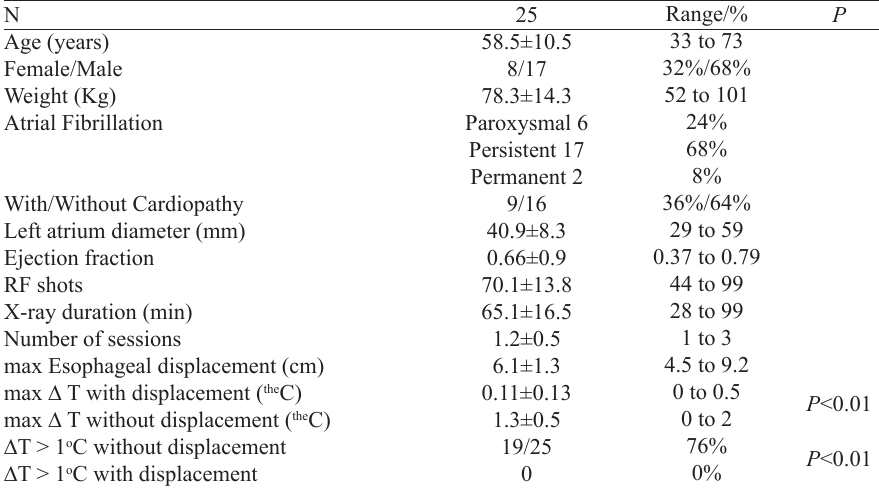
Table 2. ELT changes with and without esophageal displacement. In 19/25 (76%) patients the RF was interrupted due to ELT increase > 1 o C during one RF delivery at